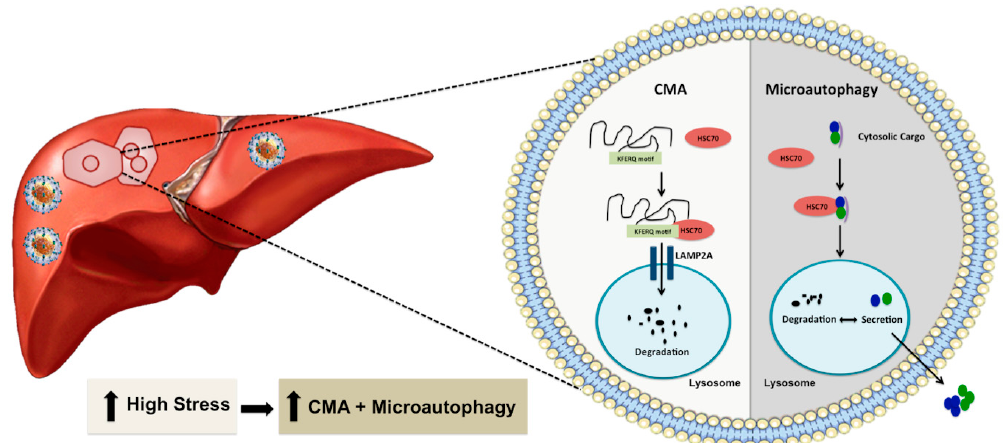
Figure 3. Shown is an illustration demonstrating through which excessive cellular stress at the ER activates other two forms of autophagy (microautophagy or CMA) as an efficient cellular compensatory process to reduce cellular stress and improve cell survival. CMA requires a specific cytosolic protein containing a KFERQ-like pentapeptide sequence that is recognized by HSC70 and subsequently translocated into the lysosomal lumen via interaction with LAMP2A for degradation. Microautophagy involves direct incorporation of cytoplasmic materials into endosomes or lysosomes for either degradation or export outside to reduce cellular stress. Microautophagy is also involved in the exosome secretion of cytoplasmic cargo to reduce cellular stress.